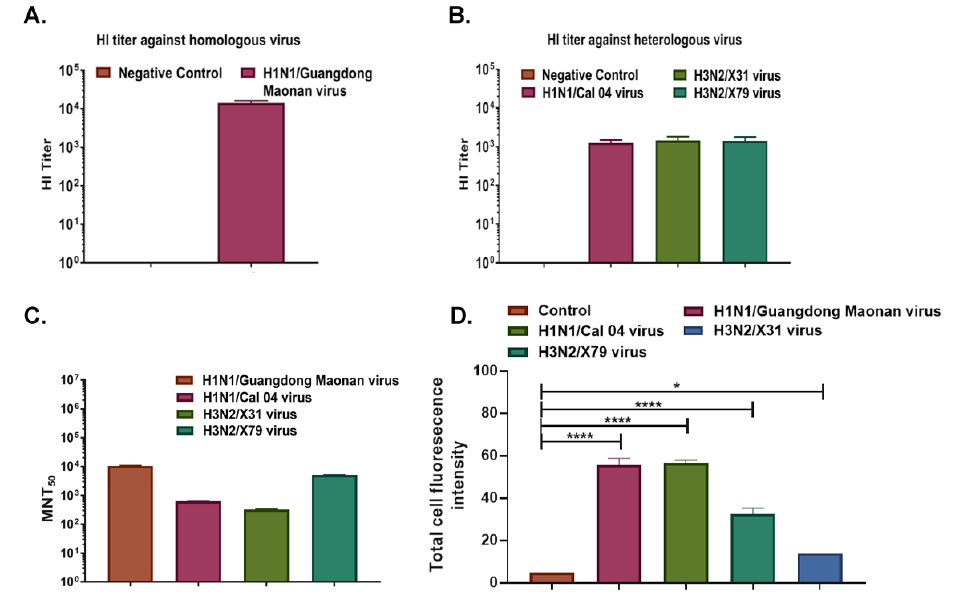
Figure 6. A broad range of cross-protection by HA-T-AGM boost sera against virus subtypes. ( A ): HI titer of Anti-HA-T-AGM vaccinated sera against the homologous strain of the virus (Inf A/H1N1/Guangdong Maonan) ( B ): HI titer of Anti-HA-T-AGM vaccinated sera against heterologous strains of the virus (Inf A/H1N1/Cal 04; Inf A/H3N2/X-31; Inf A/H3N2/X-79) ( C ): Microneu- tralization Assay showing MNT 50 titer of HA-T-AGM boost sera against different virus subtypes showing cross-protection. ( D ): Influenza A / Guangdong HA-T-AGM anti-sera cross-reactivity with other Influenza viruses as shown with Immunofluorescence assay. The data represented here is mean with SE. The normality of the samples was assessed with the Shapiro-Wilk normality test; statistical analysis was then performed using Student’s t-test. * p < 0.05 and **** p < 0.0001.